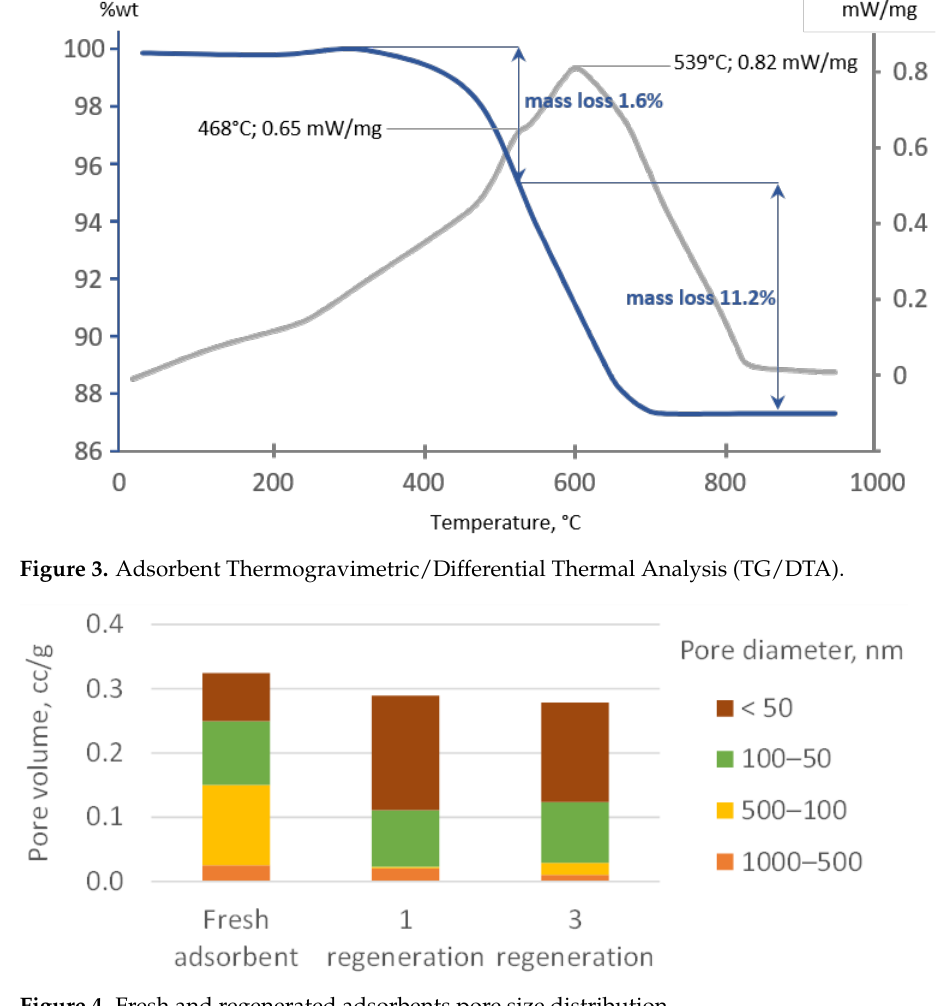
Figure 4. Fresh and regenerated adsorbents pore size distribution.